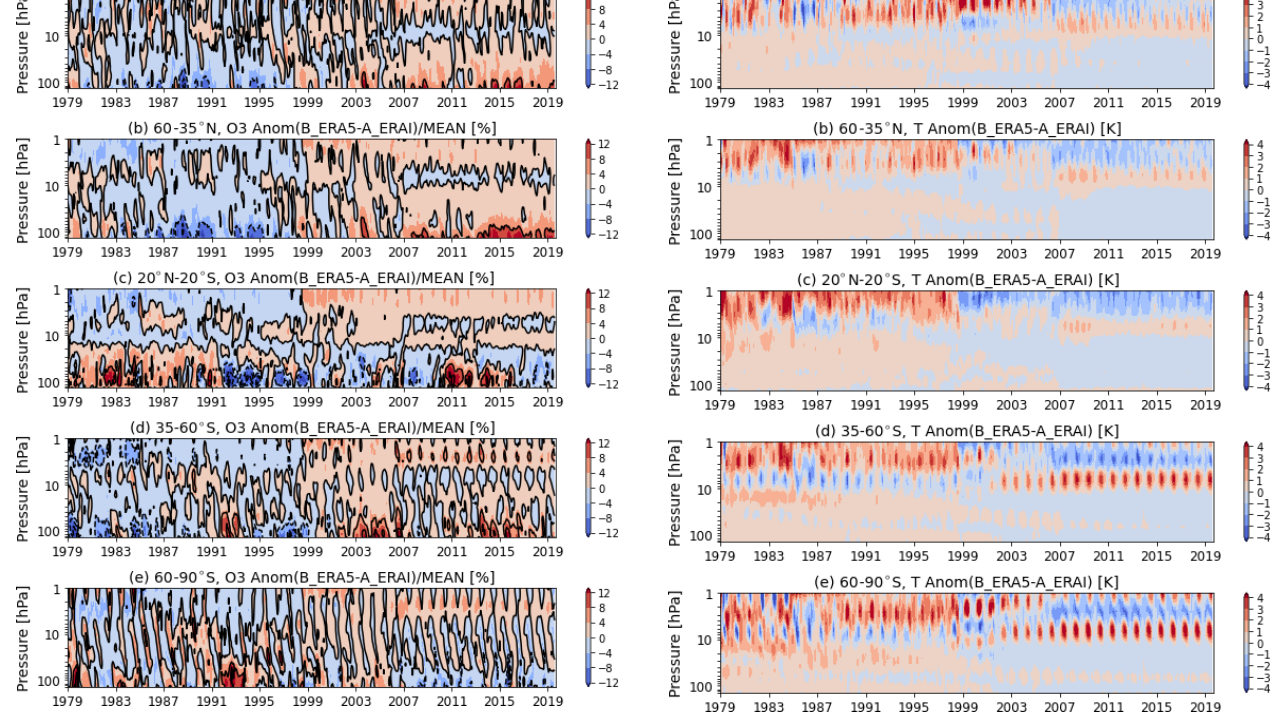
Figure 8. Similar to Fig. 7 but for differences in tempera- ture anomalies (K) between A_ERAI and B_ERA5 (B_ERA5– A_ERAI). Note the simulation B_ERA5 uses ERA5.1 reanalysis for the period